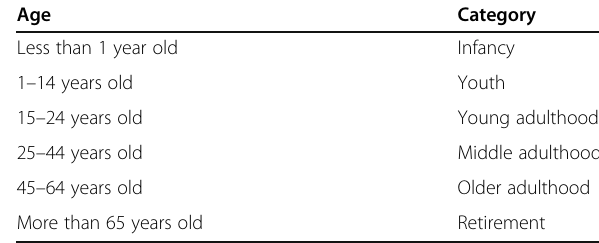
Table 1 Age groups of dengue